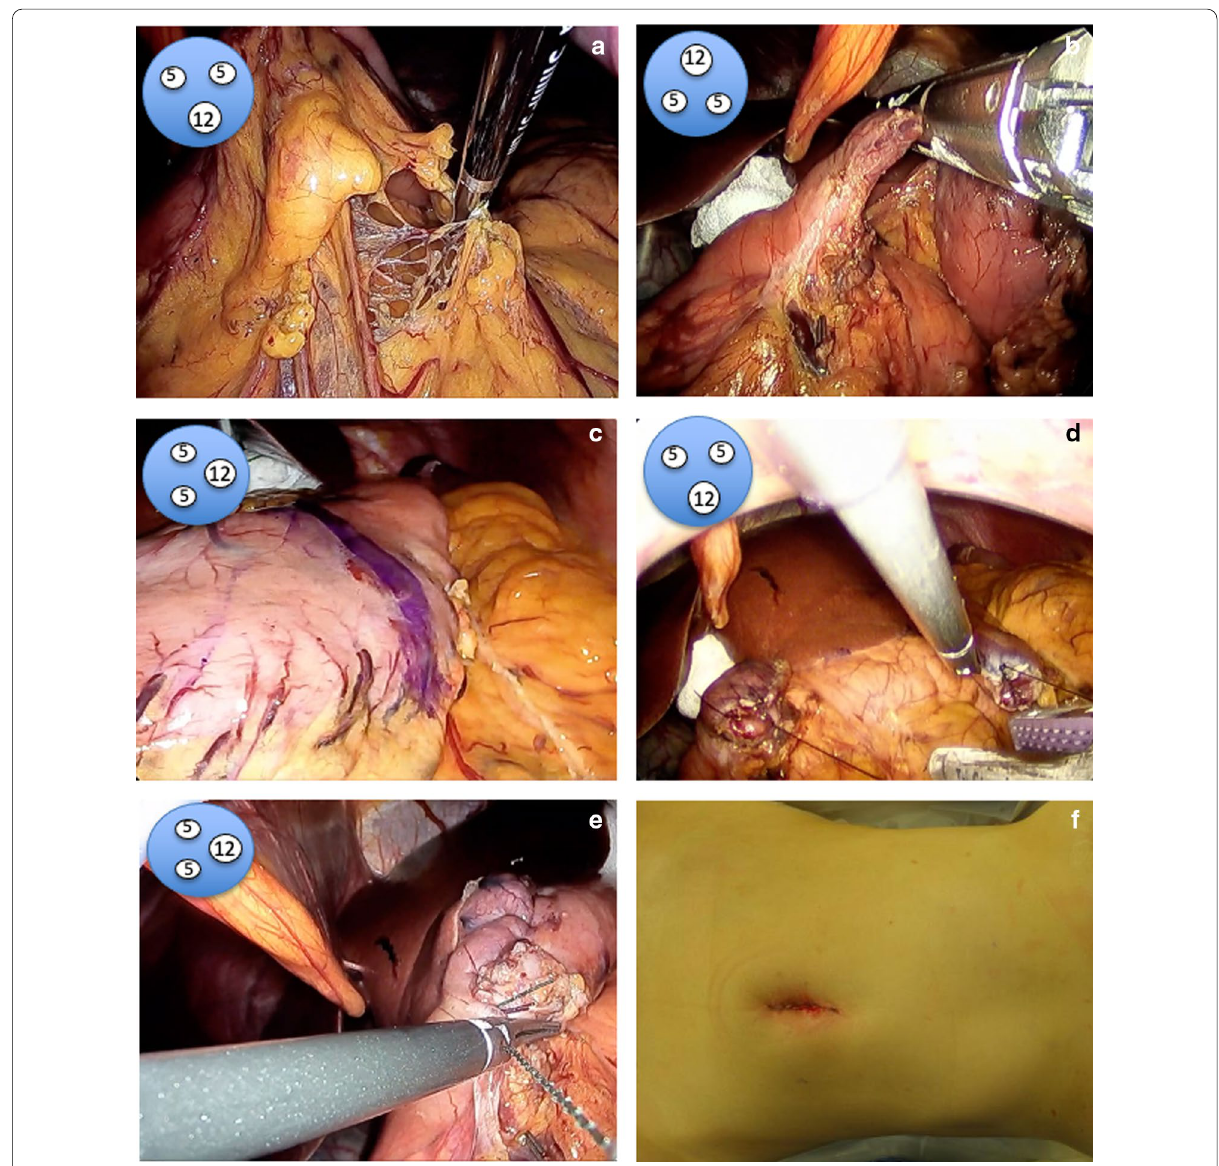
Fig. 3 The surgical procedure of SILA. a – c Antrectomy without lymph node dissection was performed using a 5 mm forward-oblique viewing endoscope, a vessel sealing device, and linear staplers. d Side-to-side anastomosis was performed between posterior sides of the duodenal stump and remnant gastric stump like the delta-shaped anastomosis. e The entry hole was sutured intracorporeally using the barbed suture material. f There was only one wound, in the umbilical region. Illustrations demonstrating rotation of the EZ access port are shown in the upper left of the